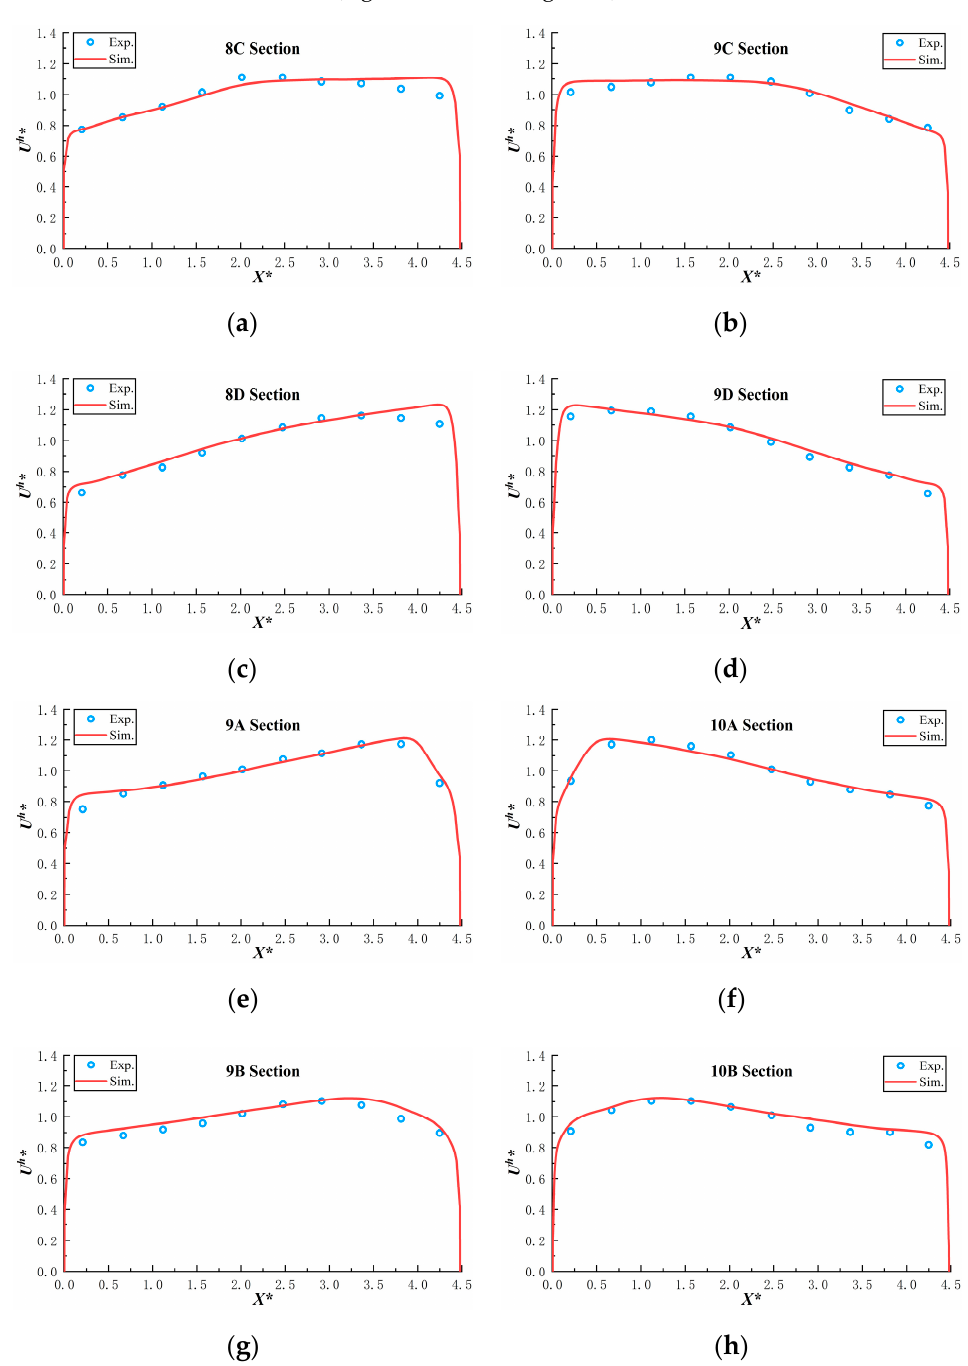
Figure 5. Comparison between simulations and measurements in dimensionless depth-averaged streamwise velocity U h * : ( a – h ) 8C to 10B cross-section along the meander in the experiment.